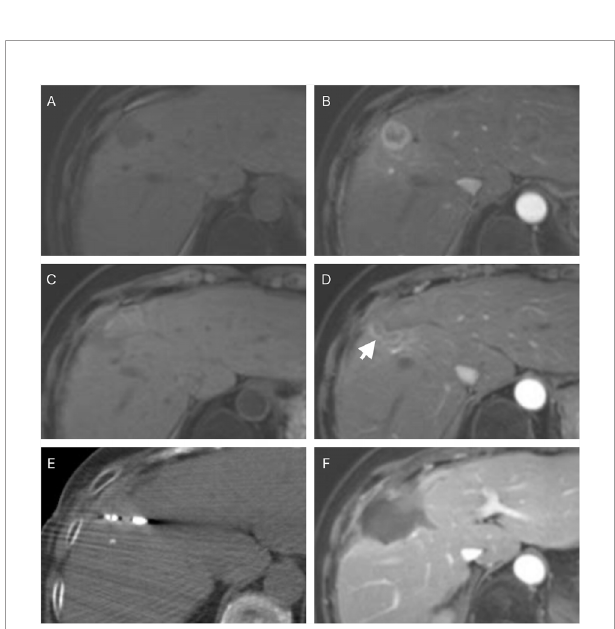
FIGURE 4 | A 56-year-old male with an imaging diagnosed hepatocellular carcinoma. The pre-ablation magnetic resonance imaging showed the lesion was in the right lobe of the liver (A) and a non-rim hyperenhancement in arterial phase (B) . The follow-up magnetic resonance imaging was performed four weeks after the ablation and showed residual tumor foci at the edge of the ablative zone (C, D) (white arrow). A transarterial chemoembolization was performed and iodized oil retention was noted (E) . Follow-up magnetic resonance imaging was performed four weeks after the transarterial chemoembolization and showed a complete response (F)